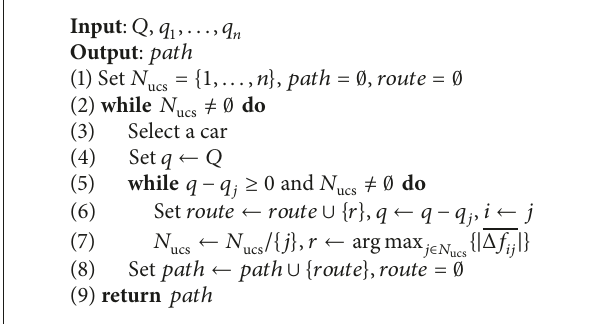
Algorithm 1: A modified nearest neighborhood heuristic.